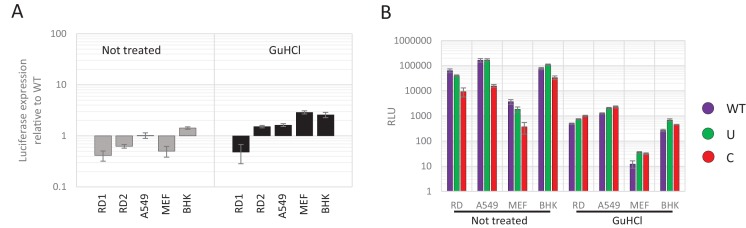
Reduced replication of E7 replicon RNA with increased CpG and UpA dinucleotides is not the result of reduced translation.(A) Indicated cell types were transfected with E7 replicon RNA with either the WT or UpA-high ncR1 sequence. RD1 shows the six hour time point from panel A and B, while RD2 is a second independent experiment in RD cells. Cells were either treated with GuHCl or left untreated. At six hpt luciferase expression was measured. Bars show the fold change in luciferase expression of the E7 replicon with the UpA-high ncR1 relative from that of their respective not treated or GuHCl treated WT. (B) Raw luciferase values from Figure 4D and Figure 4—figure supplement 1A. Bars represent the mean of three biological replicates. Error bars represent one standard error of the mean.